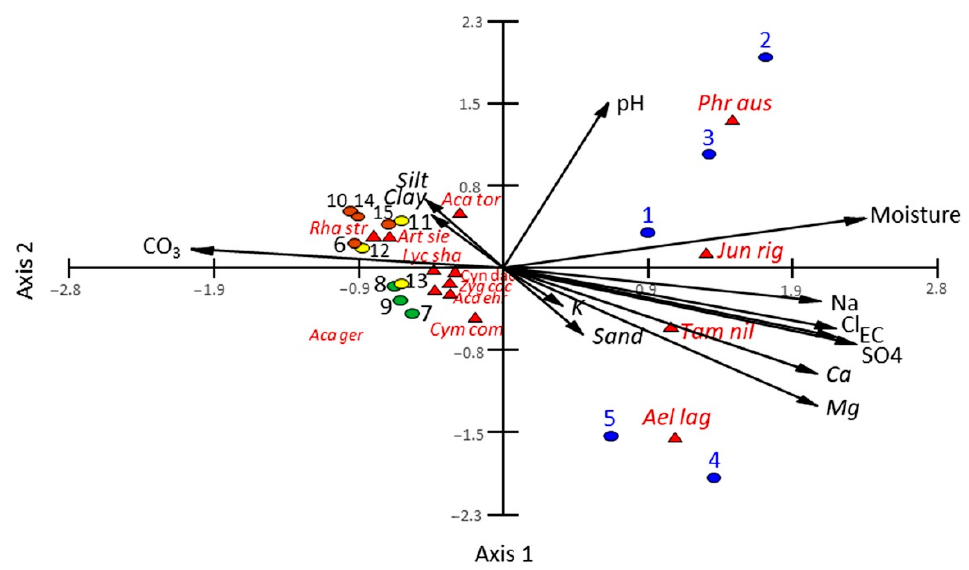
Figure 4. CCA ordination bi-plot between the soil variables and the dominant and important plant species of the four identified communities. Plant species names are abbreviated to the first three letters of both genus and species. Acacia ehrenbergiana , Acacia gerardii , Acacia tortilis , Aeluropus lagopoides , Artemisia sieberi , Cynodon dactylon , Cymbopogon commutatus , Phragmites australis , Juncus rigidus , Lycium shawii , Rhazya stricta , Tamarix nilotica , and Zygophyllum coccineum , and EC: electrical conductivity.